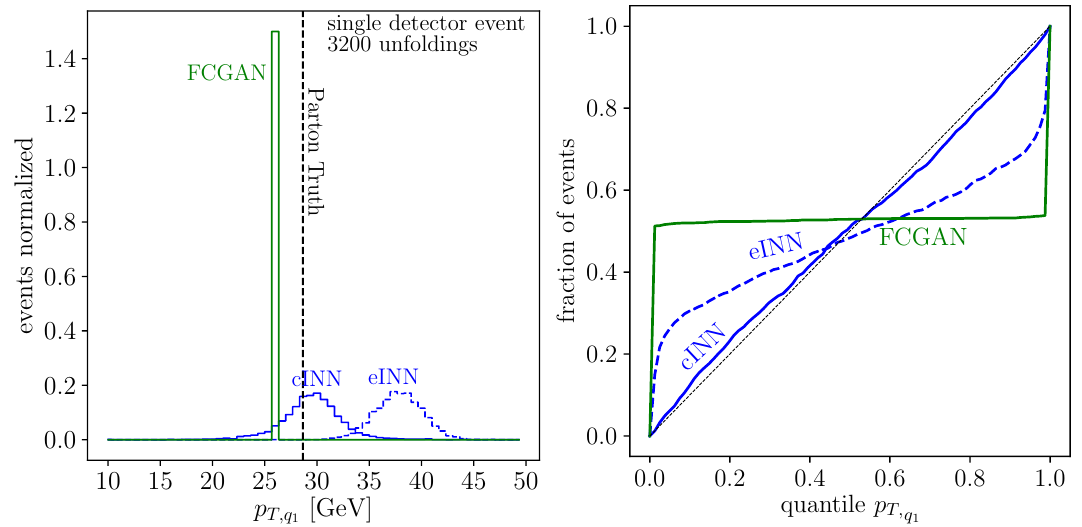
Figure 7: Left: illustration of the statistical interpretation of unfolded events for one event. Right: calibration curves for p extracted from the FCGAN and the noise- T , q 1 extended eINN, as shown in Fig. 4, and the